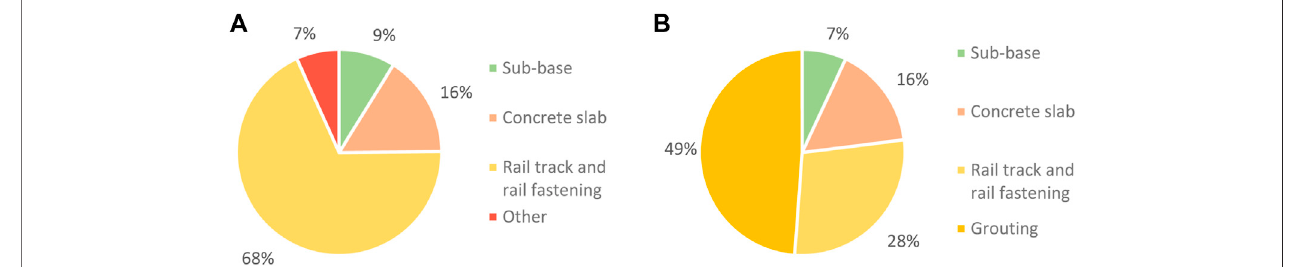
FIGURE 12 | Carbon emission for off-street (A) and street (B) construction.